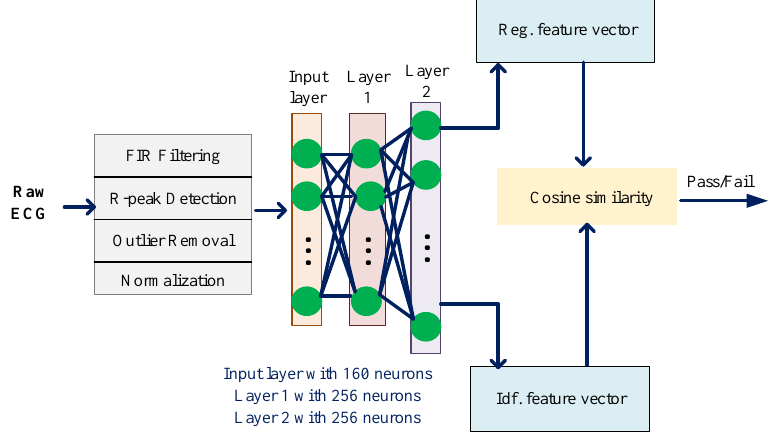
Figure 20. Employed NN for ECG